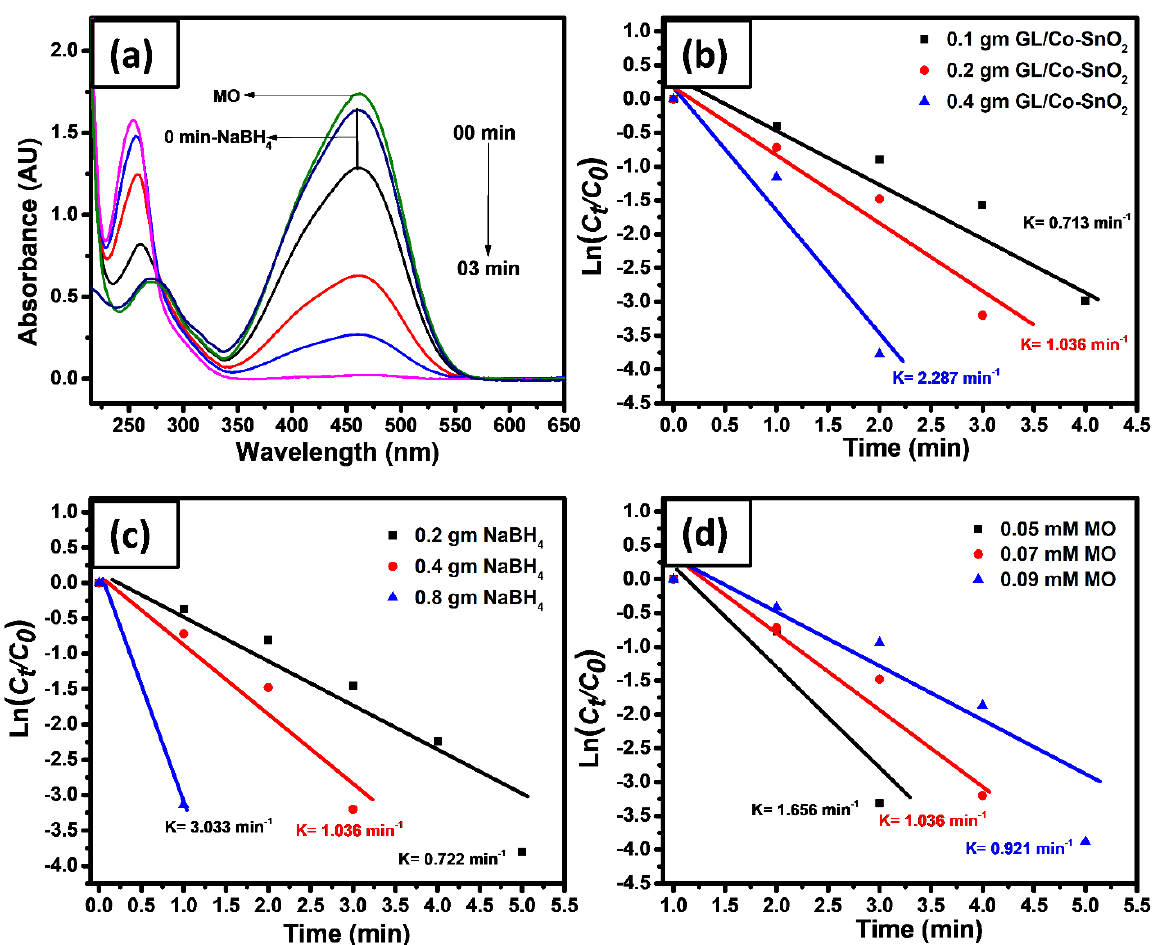
Figure 7. UV-visible spectra of MO reduction ( a ) and the plot of ln (C t /C 0 ) versus time for CR by changing the amount of GL/Co − SnO 2 catalyst, ( b ) changing the amount of NaBH 4 , ( c ) and different changing the amount of GL/Co-SnO 2 catalyst, ( b ) changing the amount of NaBH 4 , ( c ) and different concentrations of dye ( d ). concentrations of dye ( d